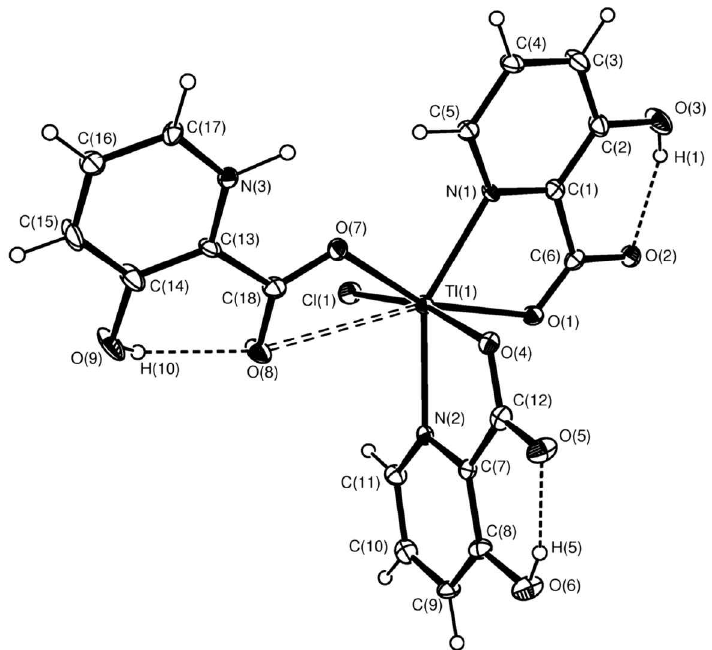
Fig. 5 ORTEP plot of the molecule of [TlCl(3hpic) 2 (H3hpic)] ( 4 ). The atoms are drawn with 30% probability